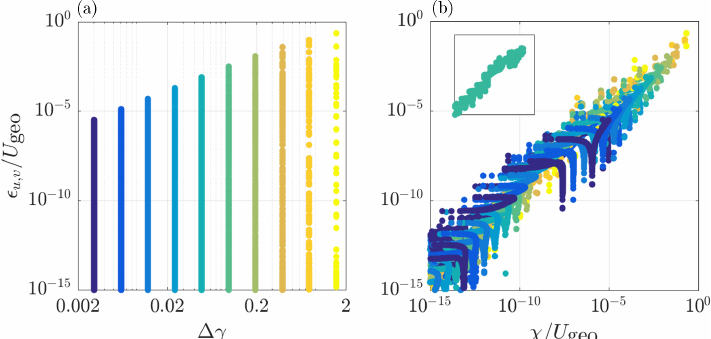
Figure 1. The locally evaluated error in the numerical solutions for u and v at t = t end , based on the analytical solution ( (cid:15) u,v , see Eq. 23) for 10 runs using different equidistant mesh-element sizes. Panel (a) shows that the diagnosed errors for each run plotted against the mesh- element size used ( (cid:49) ) times the inverse Ekman depth ( γ , see text). Panel (b) shows, with the same colour coding as in (a) , the correlation between the wavelet-based estimated error ( χ ) and the corresponding diagnosed error in the numerically obtained solution ( (cid:15) ). The inset (using the same axis scales) shows the results for a single run and reveals a spread of several orders of magnitude in both (cid:15) and χ values.